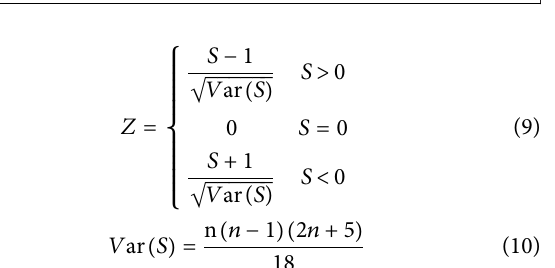
FIGURE 2 | Air temperature correlation analysis of the CRU reanalysis data and meteorological observations from 1901 to 2019 (A) and their monthly comparison (B)